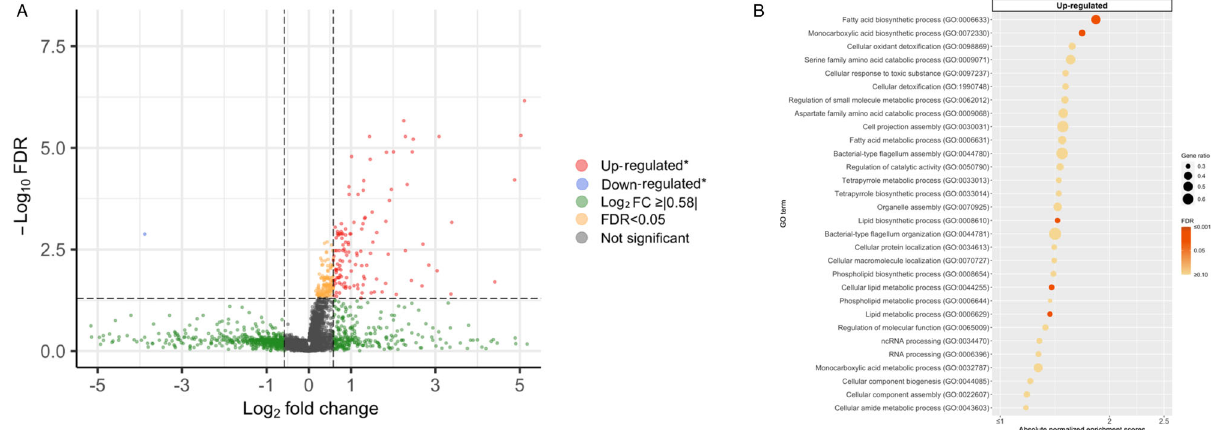
Fig. 4 | Differential gene expression analysis of microbial function data with regard to the use of positive pressure ventilation in infants hospitalized for bronchiolitis. A Volcano plot of differentially expressed microbial transcripts (metatranscriptome). The threshold of log2 fold change is |0.58| (i.e., ≥ |1.5|-fold change),andthatofFDRis<0.05.Therewere129differentiallyexpressedmicrobial transcripts that met these criteria. B Gene set enrichment analysis (GSEA) of the